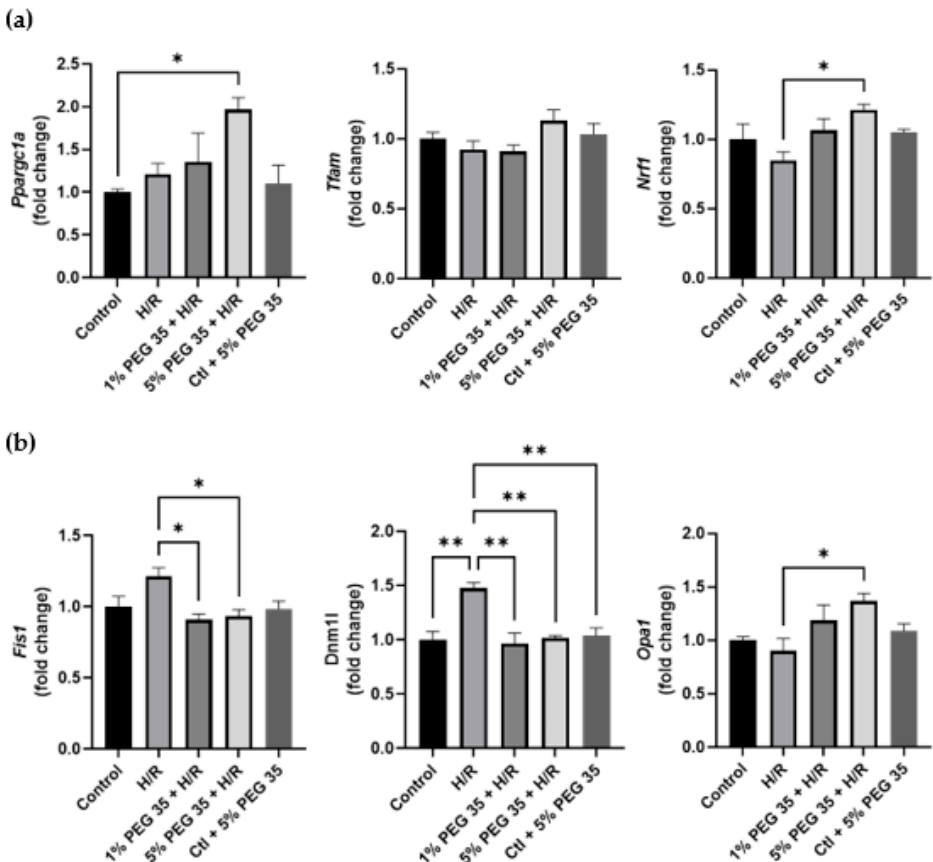
Figure 5. Effect of PEG35 preconditioning on mitochondrial biogenesis and fusion–fission dynamics during HRI. ( a ) Gene expression of proteins involved in mitochondrial biogenesis ( ppargc1a , tfam and nrf1 ). ( b ) Gene expression of mitodynamics-involved proteins, dynamin-related protein 1 (dnm1l), fission protein 1 ( fis1 ) and optic atrophy 1 ( opa1 ). The values shown represent the mean ± SEM of 3 independent experiments. * p < 0.05; ** p < 0.01.